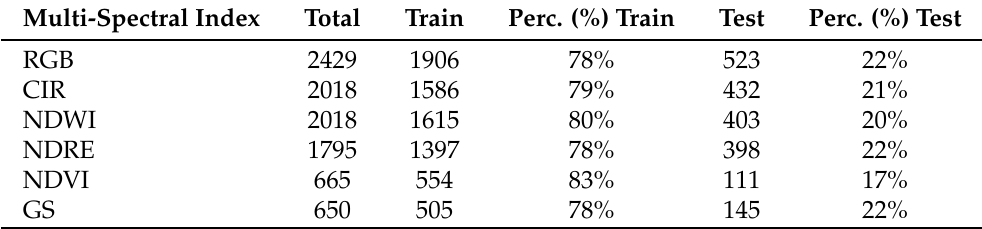
Table 2. Number of images per multi-spectral Index. Second dataset used for training. Total: total number of images; Train: total number of images used in training; Test: total number of images used for testing. Approximately 20% of Total was used for